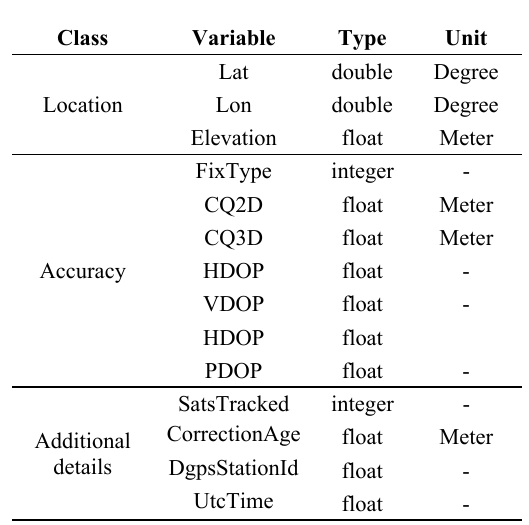
Table 4 : Environment variables delivered by the service